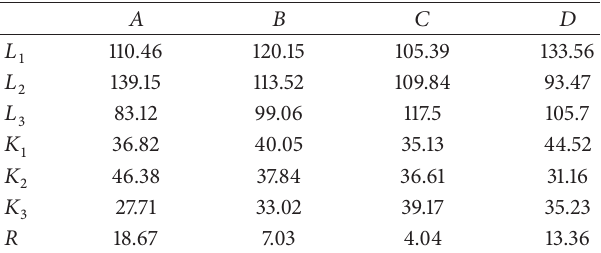
Table 6: Range analysis with efficiencies of COD removal for